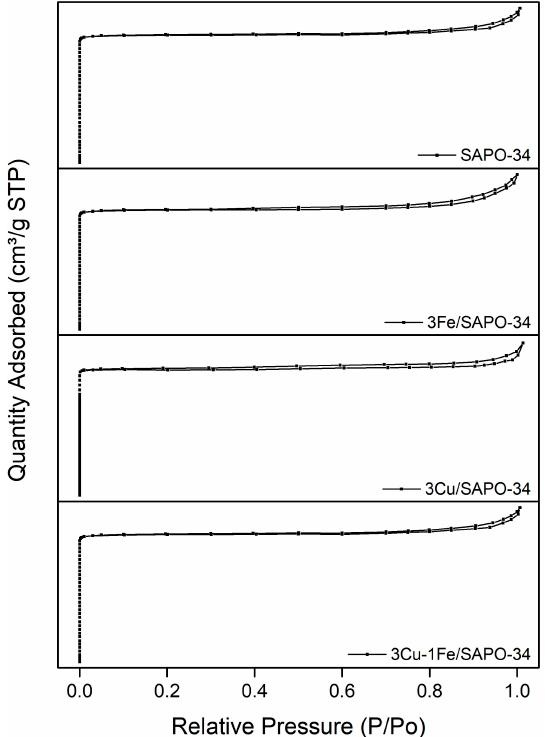
Figure 2. Nitrogen adsorption-desorption isotherms of as-synthesized Figure 2 . Nitrogen adsorption-desorption isotherms of as-synthesized samples.